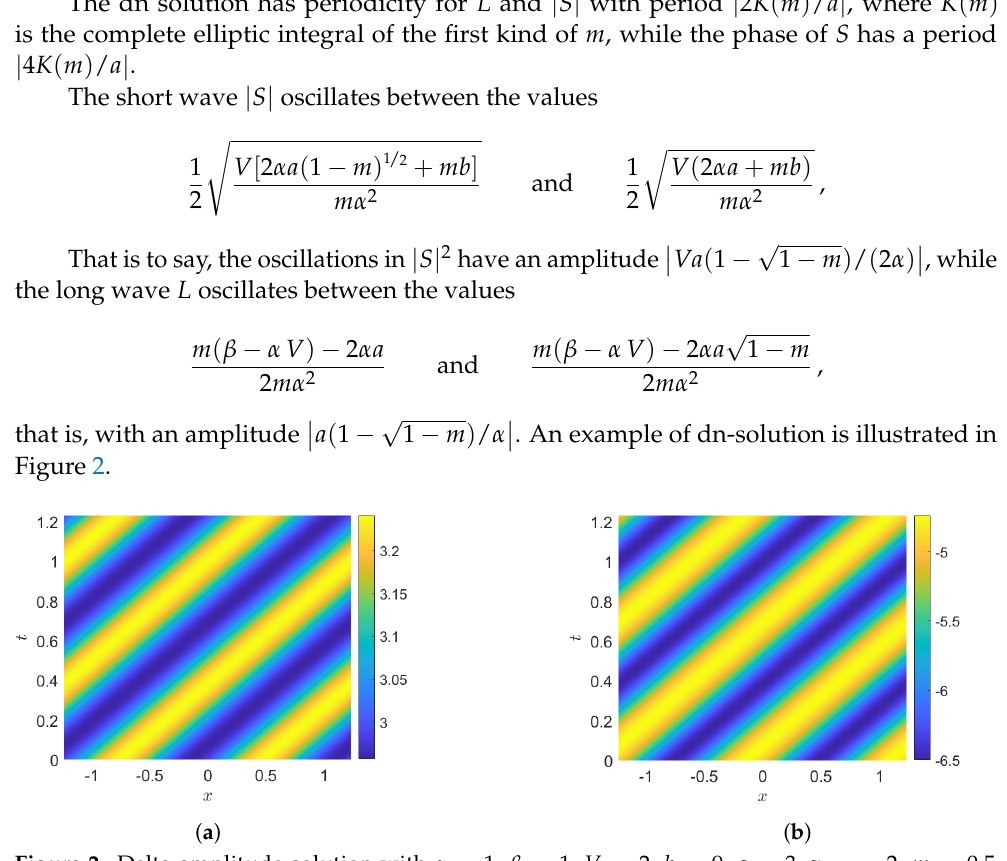
Figure 2. Delta amplitude solution with α = 1, β = 1, V = 2, b = 9, a = 3, z 0 = − 2, m = 0.5. ( a ). Short wave | S | . ( b ). Long wave L